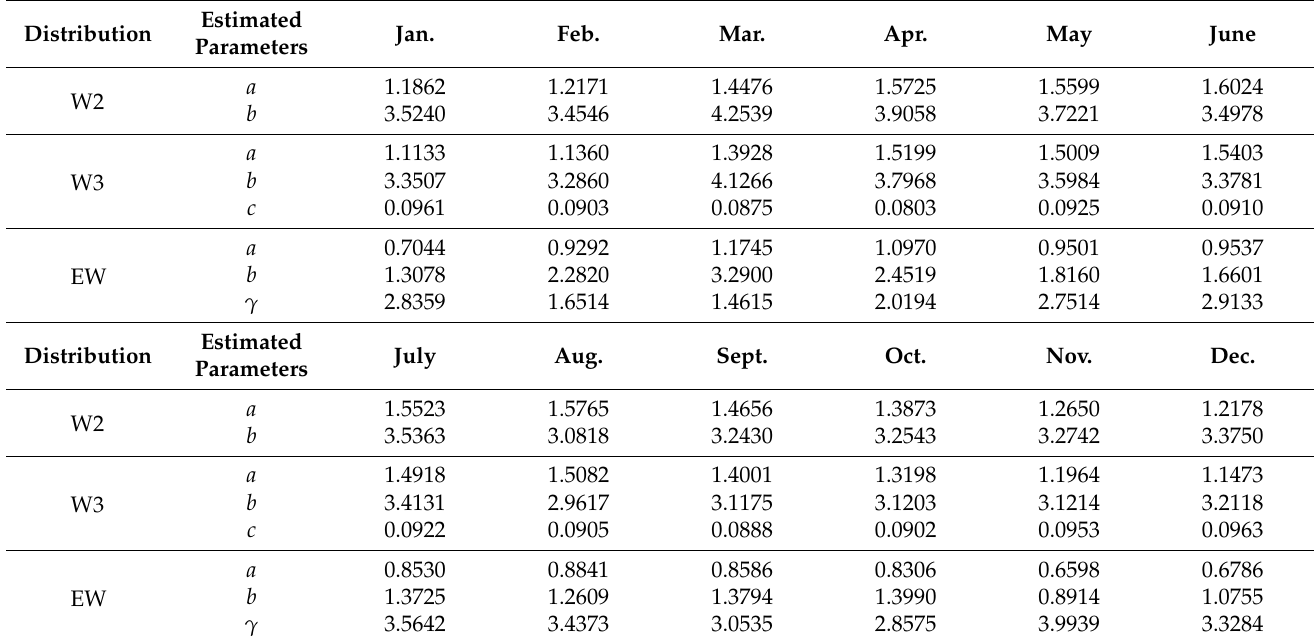
Table 7. Maximum likelihood estimates of parameters of the modelled distributions—the respec- tive